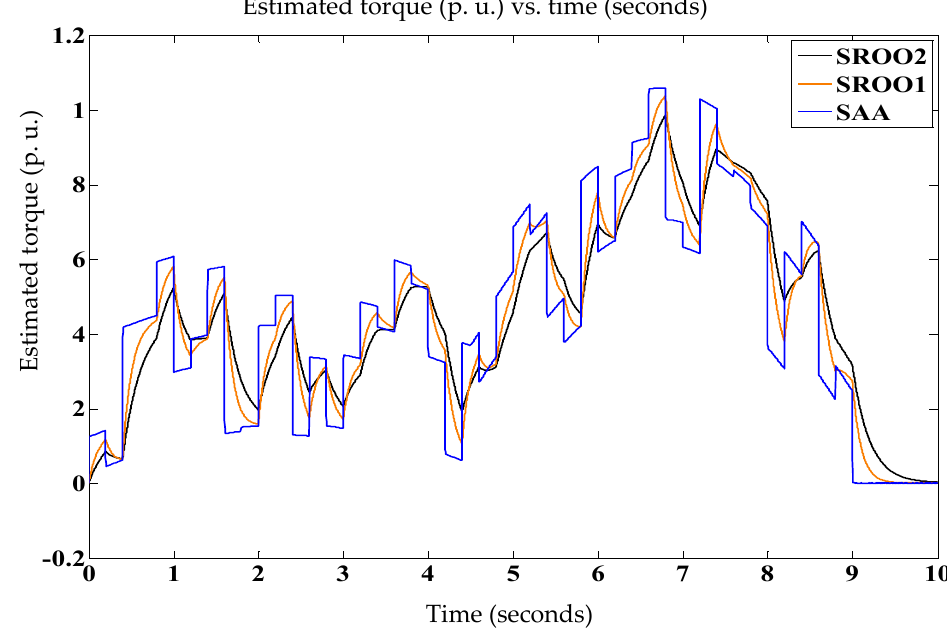
Figure 23. Estimated torque: unknown load torque.